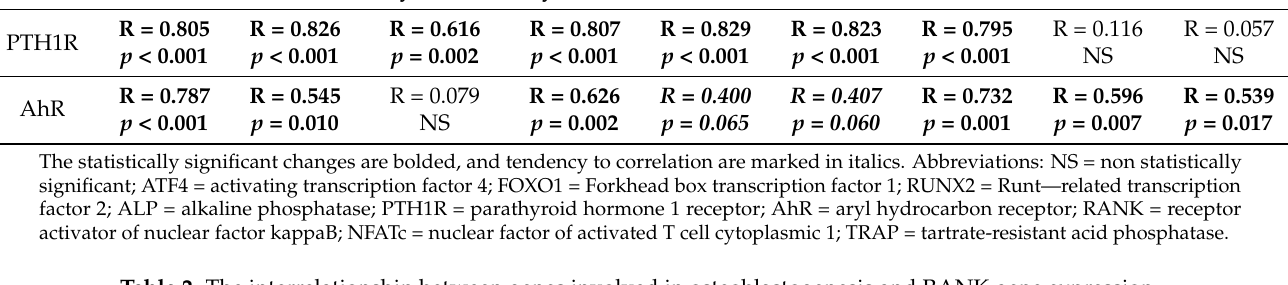
Table 1. The association between the expression of genes involved in osteogenesis and PTH1R and AhR mRNA levels. FOXO1